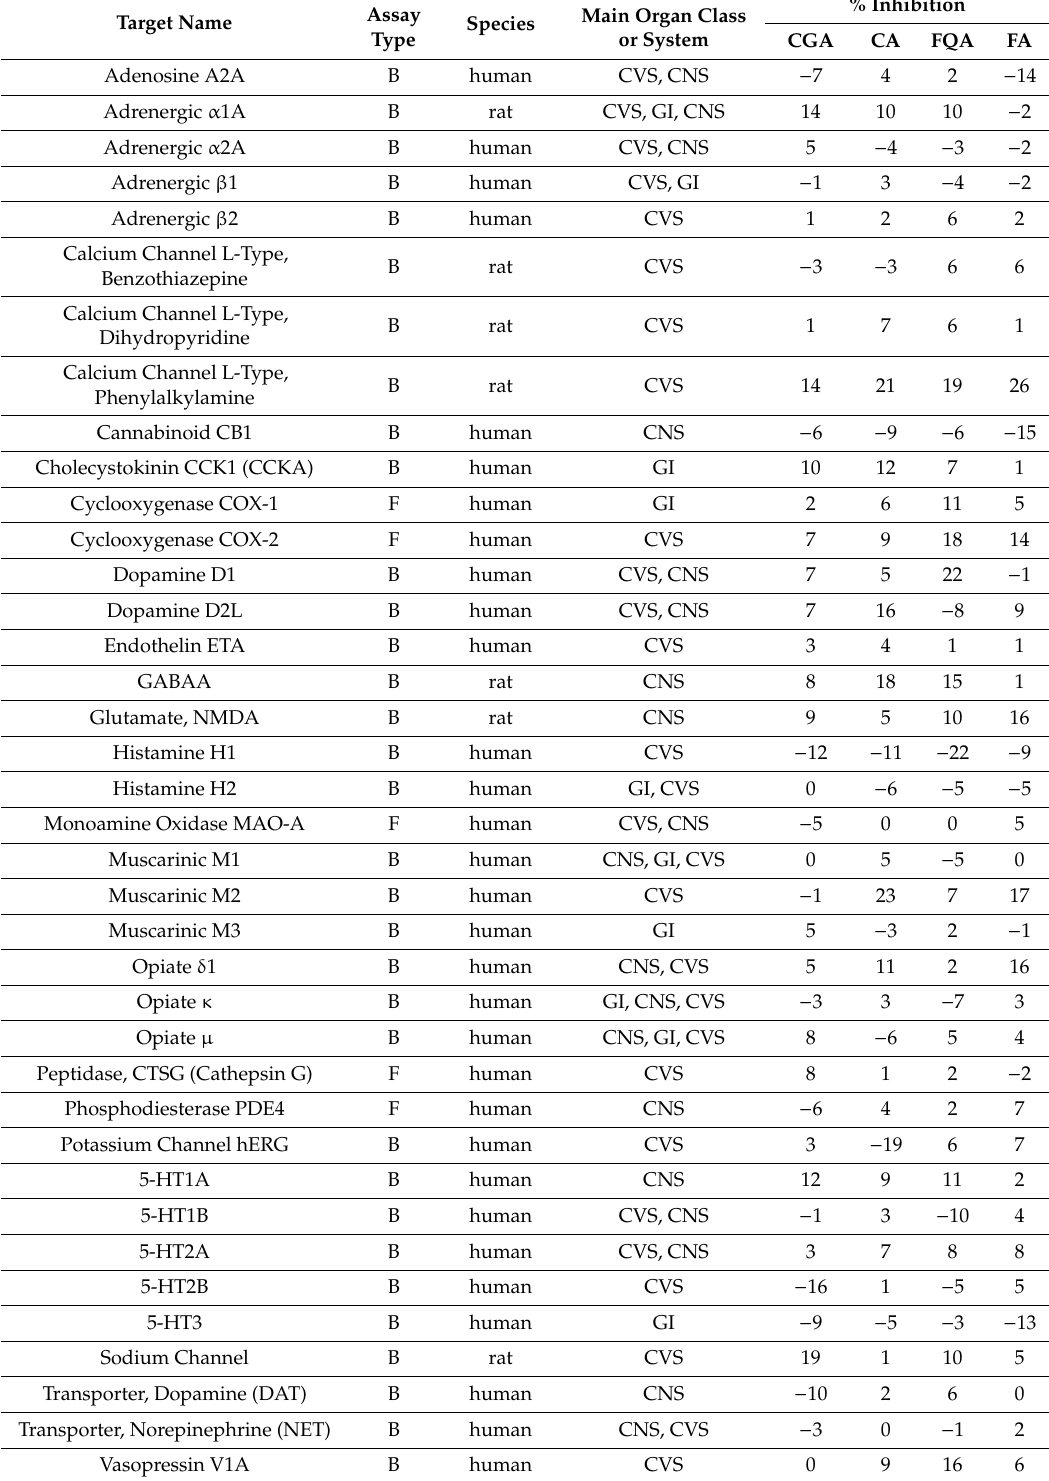
Table 2. Summary of the in vitro profiling